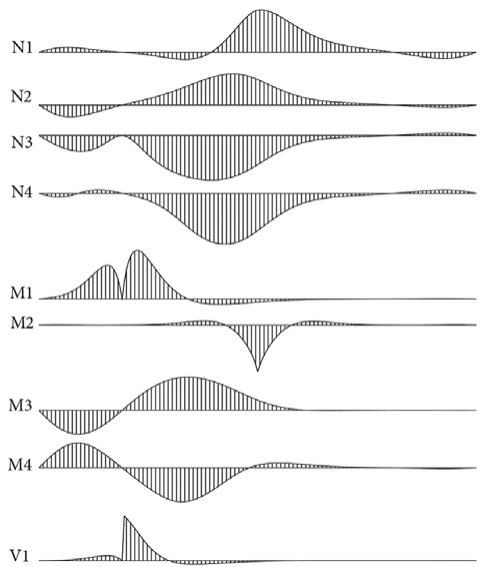
Fig. 6. Influence lines for Jēkabpils bridge: N1 – axial force in the longest cable of the central span; N2 – axial force in the longest cable of side span; N3 – axial force at the bottom of a pylon; N4 – axial force in the middle of a pylon; M1 – hogging bending moment in the deck; M2 – bending moment in the middle of the central span; M3 – bending moment at the bottom of a pylon; M4 – bending moment in the middle of a pylon; V1 – shear force in the deck next to a pylon